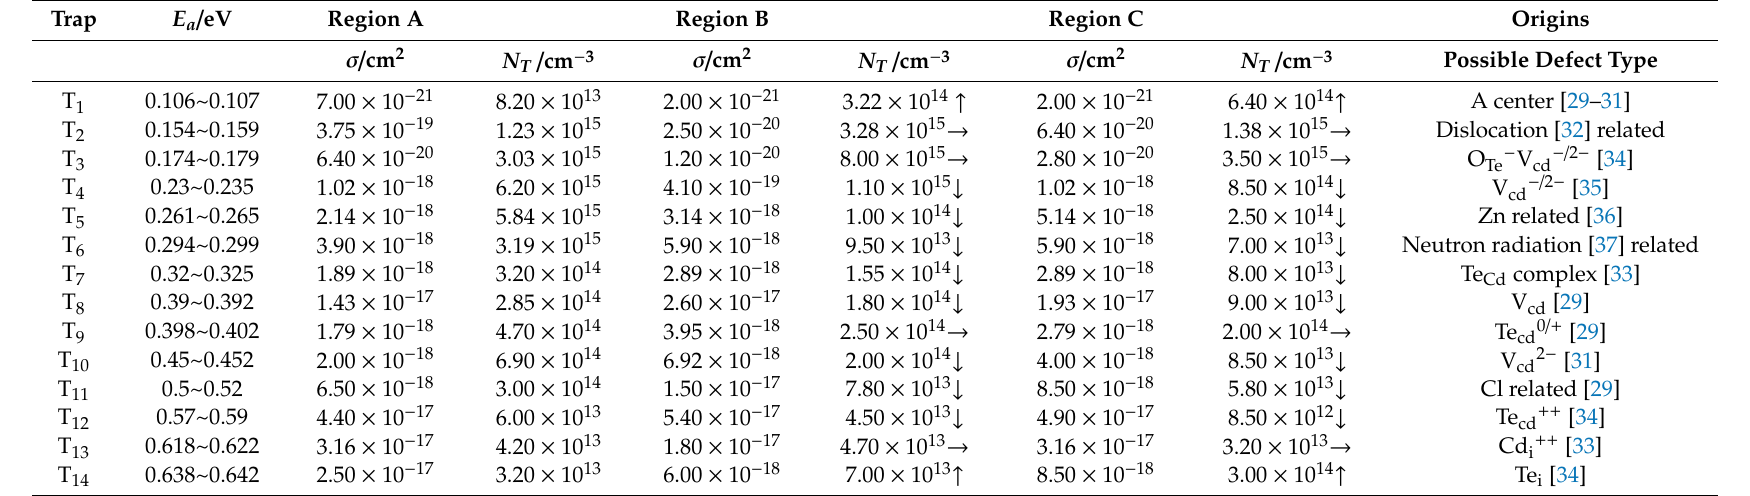
Table 1. Parameters of the TSC peaks calculated by the SIMPA method. The “ ↑ ”, “ → ” and “ ↑ ” represent the increase, invariant and decrease of the trap level compared to the region A,